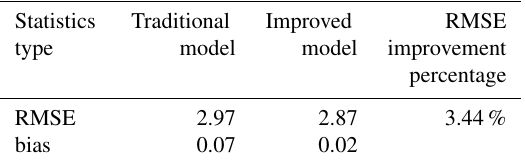
Table 3. Statistics of two models’ tomography accuracy with re- spect to ECMWF data in the everyday distribution scenario for the experimental period (unit: gm − 3